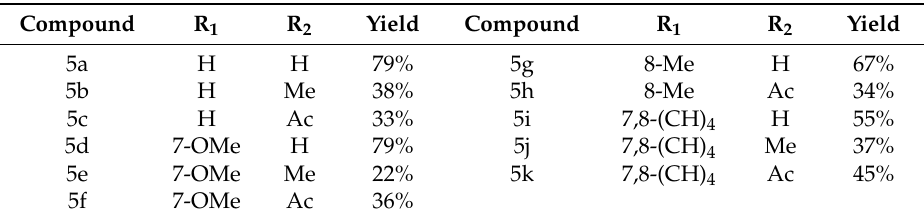
Table 3. The yields and structures of compound 5